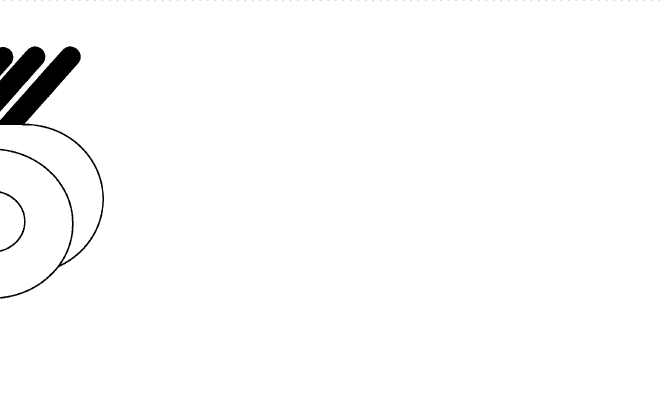
Figure 9. Waveforms of ground fault CM currents at ground resistance 1 k (cid:31) while: ( a ) CM voltage and CM current for M 0, ( b ) CM voltage and CM current for M = 0.85 (the inverter output basic harmonic frequency ≈ is 35 Hz).